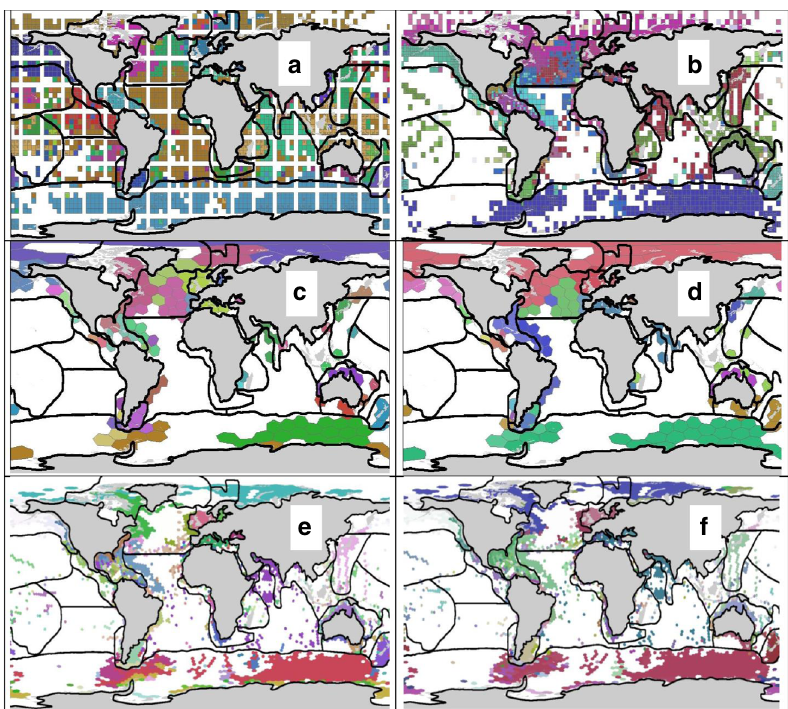
Fig. 2 Maps of the realms overlaid on results of biogeographic analyses. The biogeographic realms are denoted with black lines. Top row is using InfoMaps on the a 2009 ( n = 65,000 species, 107 clusters) and b 2015 ( n = 51,670 species, 140 clusters) data from OBIS. Results of analysis of the OBIS 2015 data is shown for two sizes of hexagons (600,000 - 800,000 km 2 and ~50,000 km 2 ) using c Sorenson ’ s (38 clusters, 0.8 similarity cutoff), d Simpson ’ s (43 clusters, 0.8 cutoff), e Sorenson ’ s (252 clusters, 0.86 cut off), and f Simpson ’ s (252 clusters 0.75 cut off), similarity coef fi cients. The geographic gaps in b – f are because only cells with >50 samples (data with same time and place and one or more species) were used for analysis of the OBIS 2015 data. Colours were automatically assigned by the software to show cells belonging to the same biogeographic group, and are not comparable across